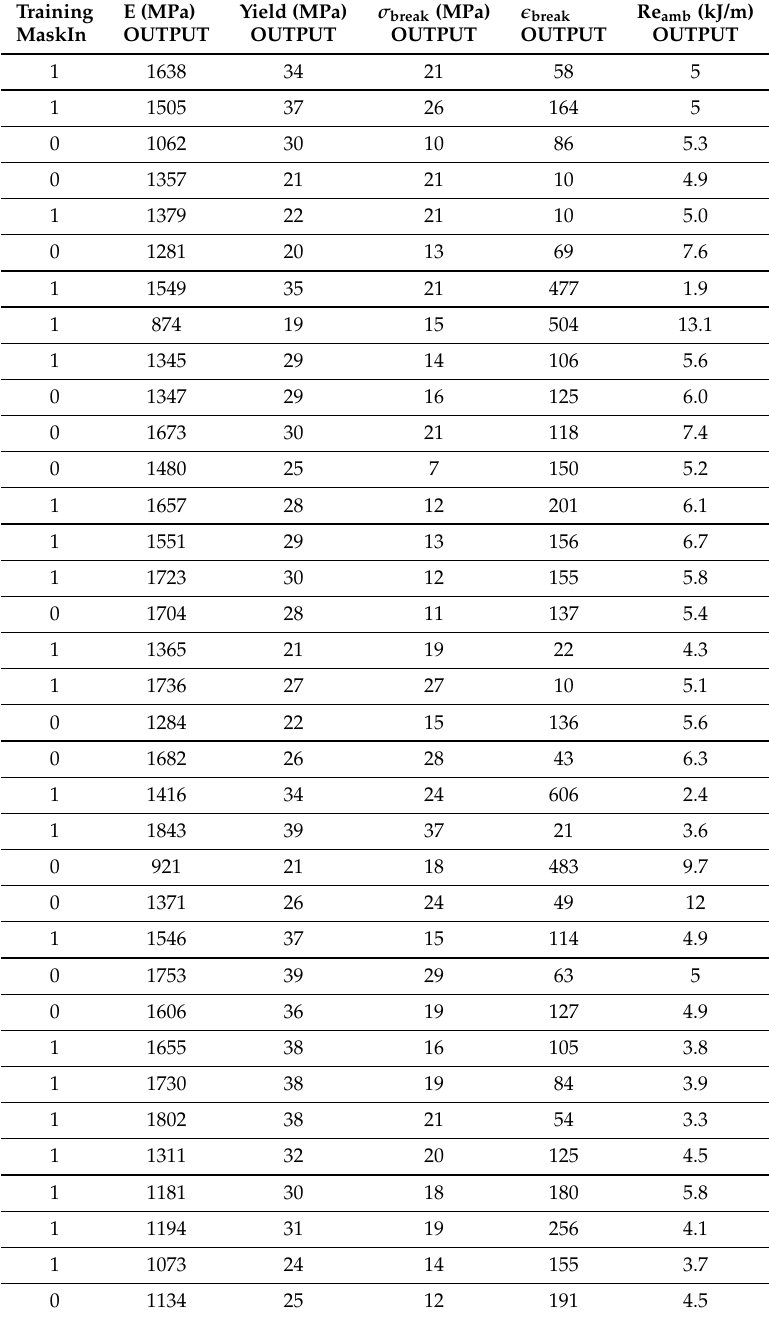
Table A2. Output quantities of